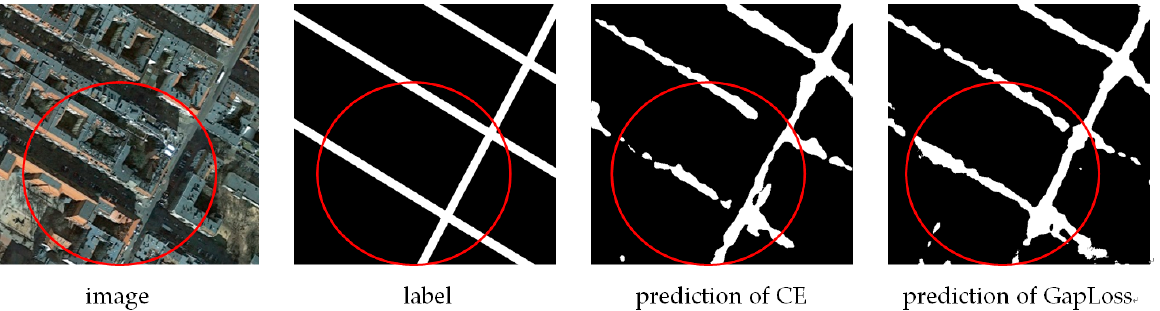
Figure 10. SegNet results with CE and GapLoss on Aerial Image Segmentation Dataset.